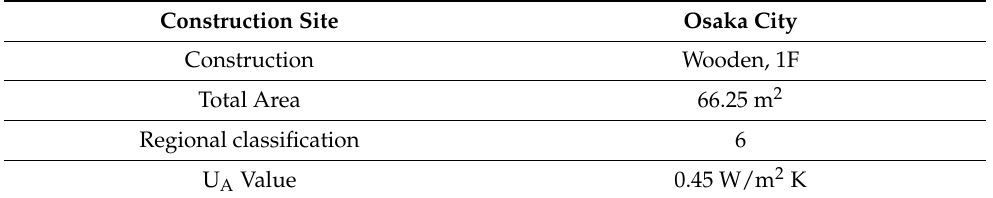
Figure 1. Plan and section of proposed ZEH [12]. Table 2. Outline of proposed